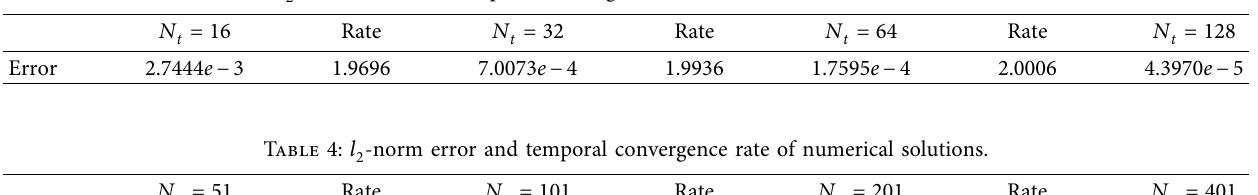
Figure 15: Convergence of the numerical solutions with respect to Δ t values. Table 3: l -norm error and temporal convergence rates of the second-order accurate scheme. 2